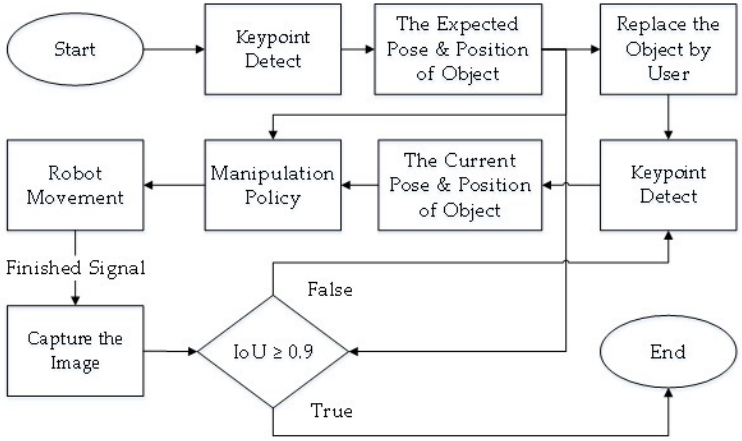
Figure 12. Flow chart of the experiment of the proposed manipulation planning for the object